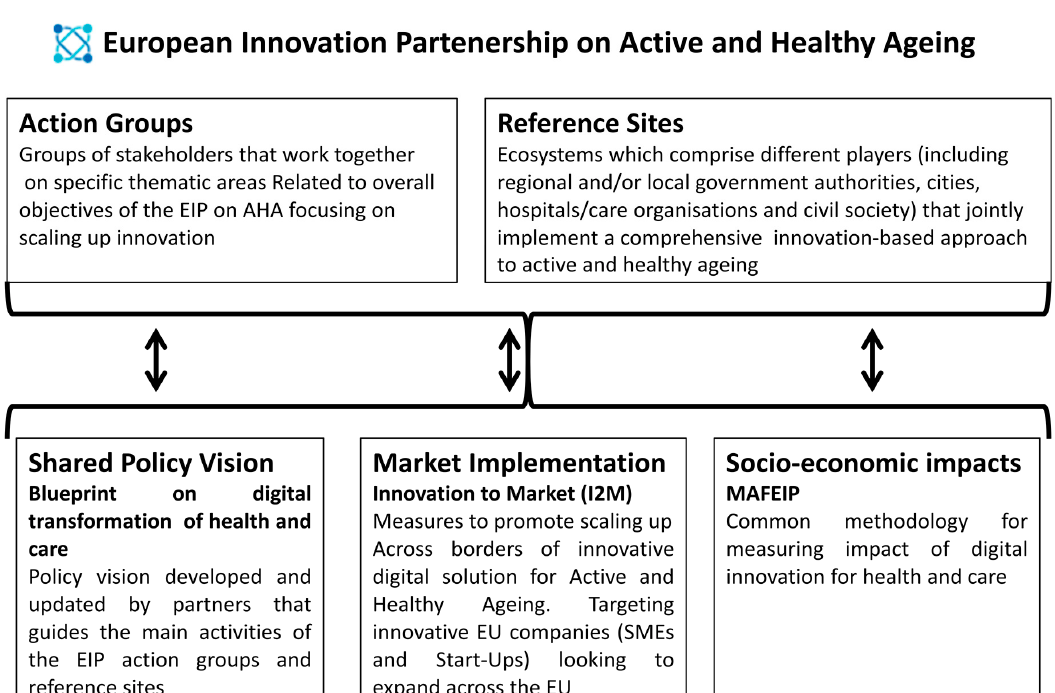
Figure 1. The structure of the European Innovation Partnership on Active and Healthy Ageing (EIP on AHA).